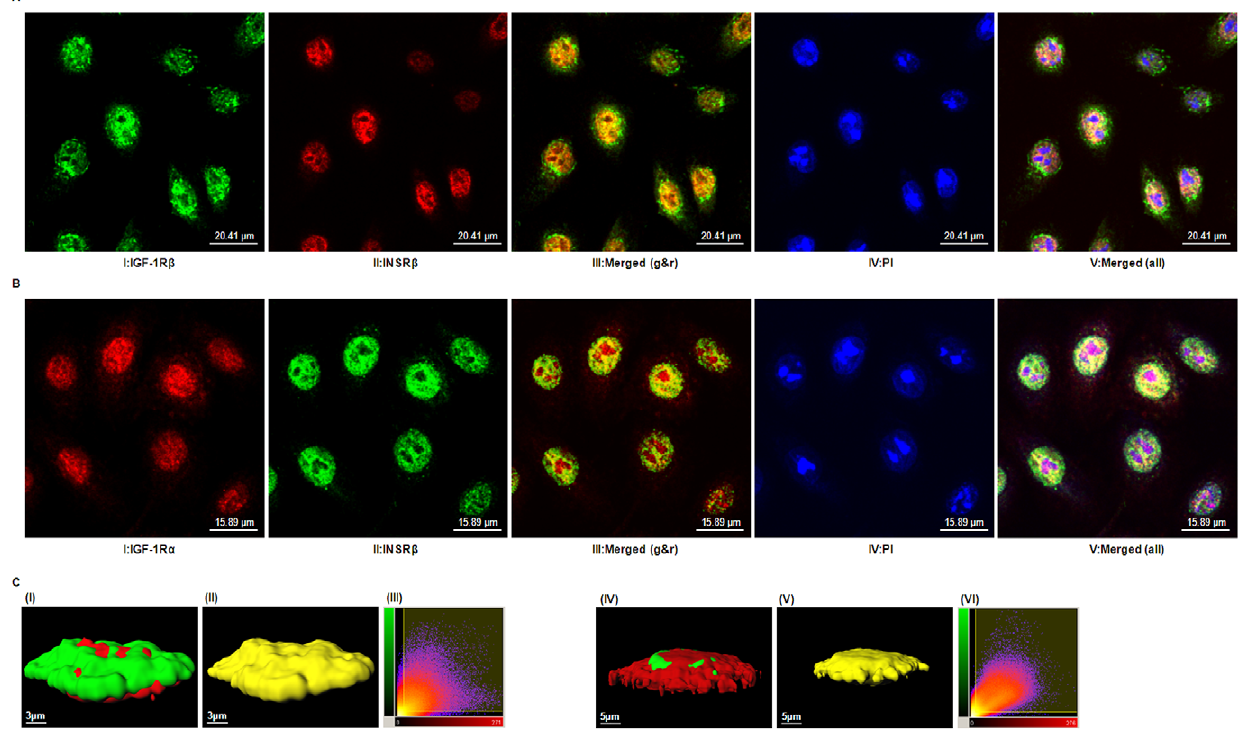
Figure 5. Co-localization of IGF-1R and INSR. (A) Confocal images showing hTCEpi cells labeled with antibodies against IGF-1R b (CST # 3027) ( panel I , revealed by green ), INSR b (CT-3) ( panel II , revealed by red ), or both ( panel III , merged by panels I and II); nuclei were counterstained with PI ( panel IV , revealed by blue ) and overlap of the three channels is shown in panel V . Scale: 20.41 m m. (B) Confocal images showing hTCEpi cells labeled with antibodies against IGF-1R a (24–31) ( panel I , revealed by red ), INSR b (C-19) ( panel II , revealed by green ), or both ( panel III , merged by panels I and II); nuclei were counterstained with PI ( panel IV , revealed by blue ) and overlap of the three channels is shown in panel V . Scale: 15.89 m m. Orange or Yellow color in merged panels III denotes the presence of both IGF-1R and INSR immunoreactivity; white color in merged panels V represents the co- localization of both IGF-1R and INSR in the nucleus. (C) Imaris analysis of co-localization. Confocal images of hTCEpi cells labeled with antibodies as described above were further analyzed by Imaris software. The 3D reconstruction of a two-dimensional Z-stack of images illustrates the subcellular distribution of IGF-1R b (green) and INSR b (red) ( Panel I ) or IGF-1R a (red) and INSR b (green) ( Panel IV ) in hTCEpi cells. Panel II and V , co-localized voxels of panel I and IV, respectively. Scale: 3 or 5 m m. Panel III or VI shows the representative two-dimensional histogram of both signals for either panel I or IV. The red signal is on the x axis and the green is on the y axis. Automatic selected co-localized areas are shown by a rectangular yellow overlay. Data are representative of three independent experiments with 8 to10 cells imaged per